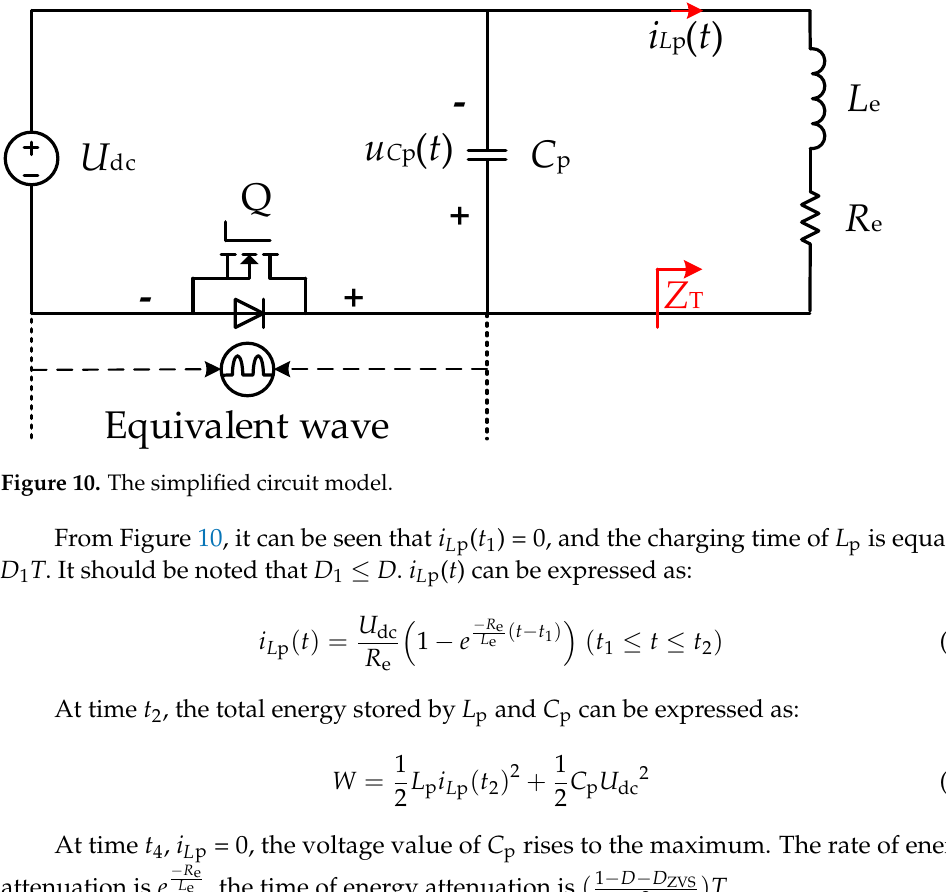
For the single-switch circuit, when the duty cycle D is fixed, the values of C p are mainly used to adjust the ZVS margin. From Figure 7, when the driving signal of Q turns off at t 2 , the C p , L e , and R e will have a zero input response, and the range values of C p can be determined from the perspective of energy attenuation. The simplified circuit model is shown in Figure 10. Here, the reflected impedances from the secondary to the primary can be expressed as Z T , Z T = j ω L e + R e .